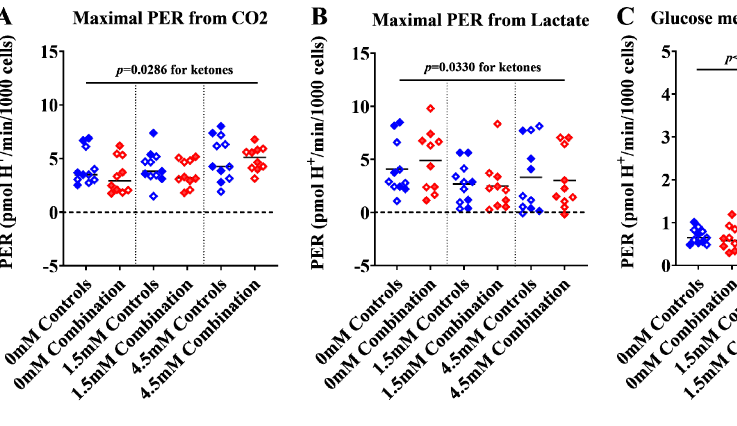
Figure 5. Maximal and glucose mediated proton efflux rate from CO 2 (PER CO2 ) increased with increasing concentrations of β HOB in both control and combination exposed cardiomyocytes. ( A ) Maximal PER CO2 , ( B ) Maximal PER from lactate (PER Lactate ), ( C ) Glucose mediated PER CO2 , and ( D ) Glucose mediated PER Lactate in control and combination exposed NRCM. Bars represent mean PER (n = 10–11 litter per group). Blue color indicates controls and red color indicates combination exposed. Open symbols in the graph indicate males and filled symbols indicate females. Ketone effect was determined by two-way ANOVA with p values above straight bars; group differences as determined by one-way ANOVA are shown with p values above footed bars. Significance accepted at p < 0.05. mM refers to the progressive concentration of β HOB supplied.